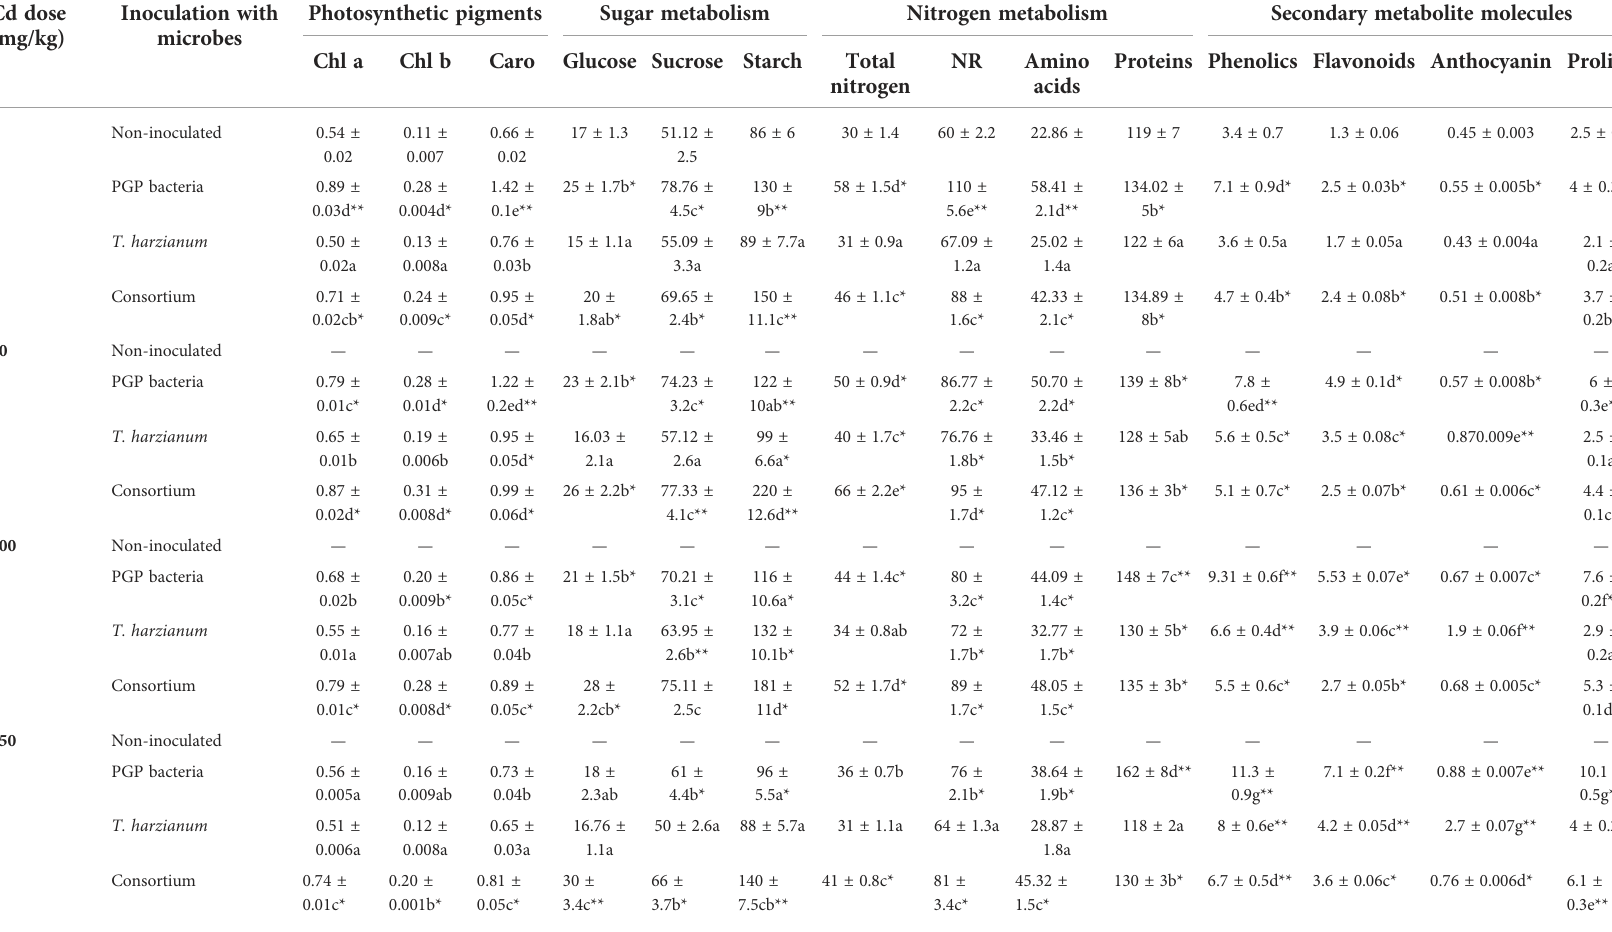
TABLE 3 Average values of photosynthetic pigments (Chl a, Chl b, and carotenoids; mg/g FW); sugar metabolism (glucose, sucrose, and starch; mg/g DW); nitrogen metabolism (TN, total nitrogen, mg/g DW; NR, nitrate reductase, m molNO 2 /g/h; amino acids, mg/g DW; and proteins, mg/g DW) and metabolic molecules (phenolics, mg/g; FW, fl avonoids, mg/g FW; anthocyanin, mg/g FW; and proline, mg/g DW) of sun fl ower inoculated and non-inoculated with PGP bacteria, T. harzianum , and Consortium and affected by different levels of Cd (0, 50, 100, and 150 mg/kg dry